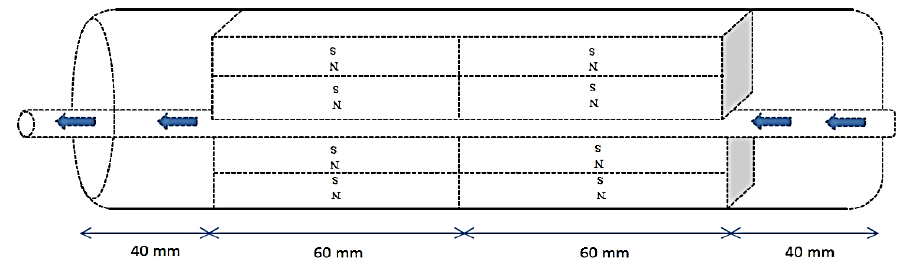
Figure 2. Sections of the magnetic device.